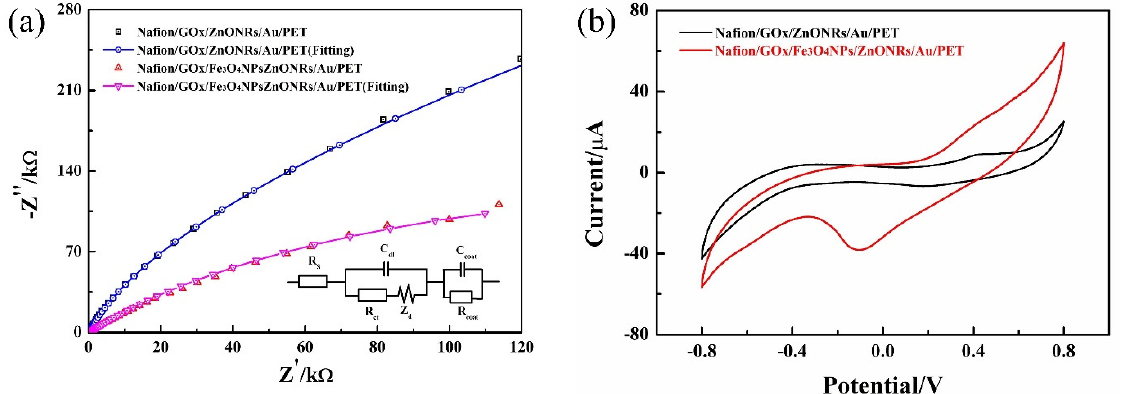
Figure 4. ( a ) The EIS curve of the Nafion/GOx/ZnONFs/Au/PET and Nafion/GOx/Fe 3 O 4 MNPs/ZnONFs/Au/PET electrodes in PBS solution. The inset shows the equivalent circuit diagram of the sensors. The frequency is from 0.01 Hz to 100 kHz, and the bias potential is +0.1 V. ( b ) Cyclic voltammograms in 3 mM glucose solution on the ZnONFs/Au/PET electrode (black line) and Fe 3 O 4 MNPs/ZnONFs/Au/PET electrode (red line). The fitting curves of the ZnONFs/Au/PET electrode (blue line) and Fe 3 O 4 MNPs/ZnONFs/Au/PET electrode (magenta line).